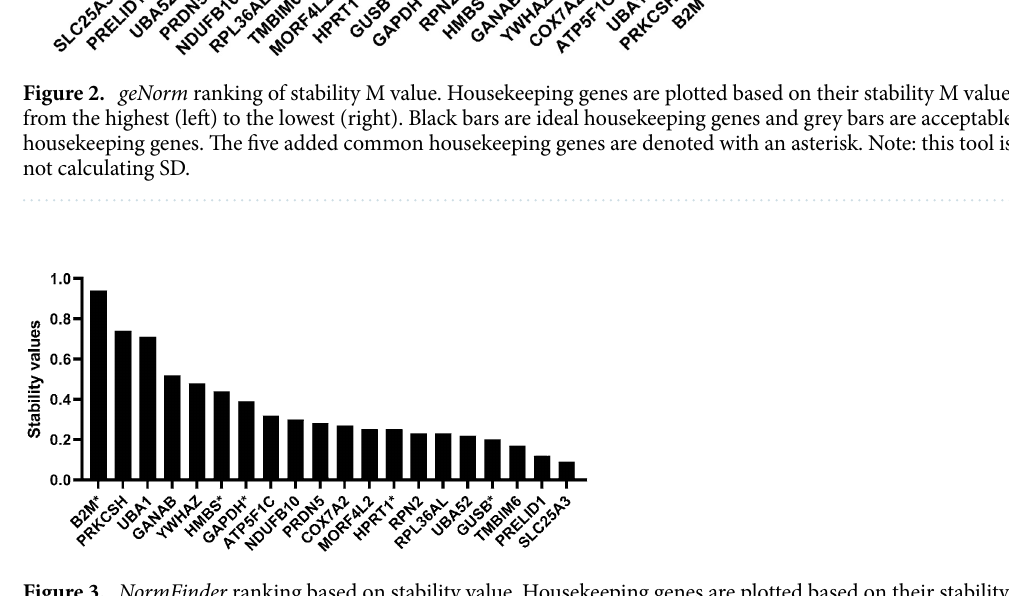
Figure 3. NormFinder ranking based on stability value. Housekeeping genes are plotted based on their stability value from the least (left) to the most stable (right). The five added common housekeeping genes are denoted with an